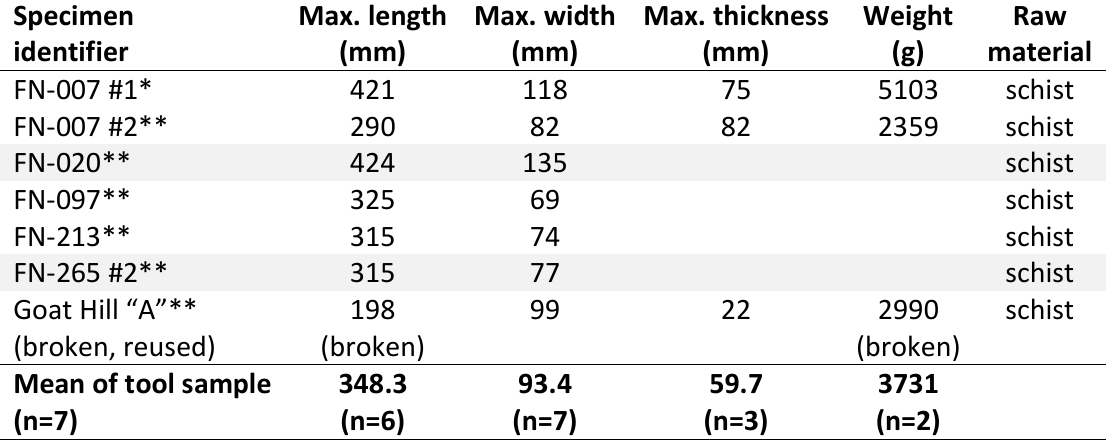
Table 3. Metric Characteristics of Pick and Mattock-shaped tools (n=7). The specimen number in bold print with one asterisk was subject to detailed metric analyses. Specimen numbers having two asterisks represent tools documented in the field or gleaned from the